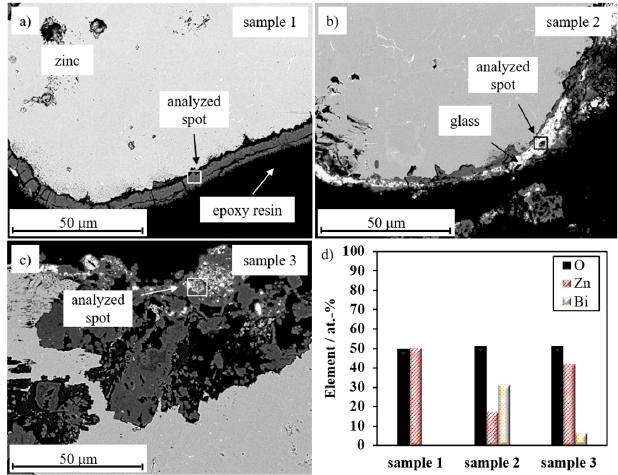
Figure 6. Post-mortem microstructural analysis (back scattered electrons) of cross sections of ( a ) sample 1 (1000 rpm, 15 min), ( b ) sample 2 (750 rpm, 30 min), ( c ) sample 3 (1000 rpm; 30 min). ( d ) EDX-analysis (10 keV).